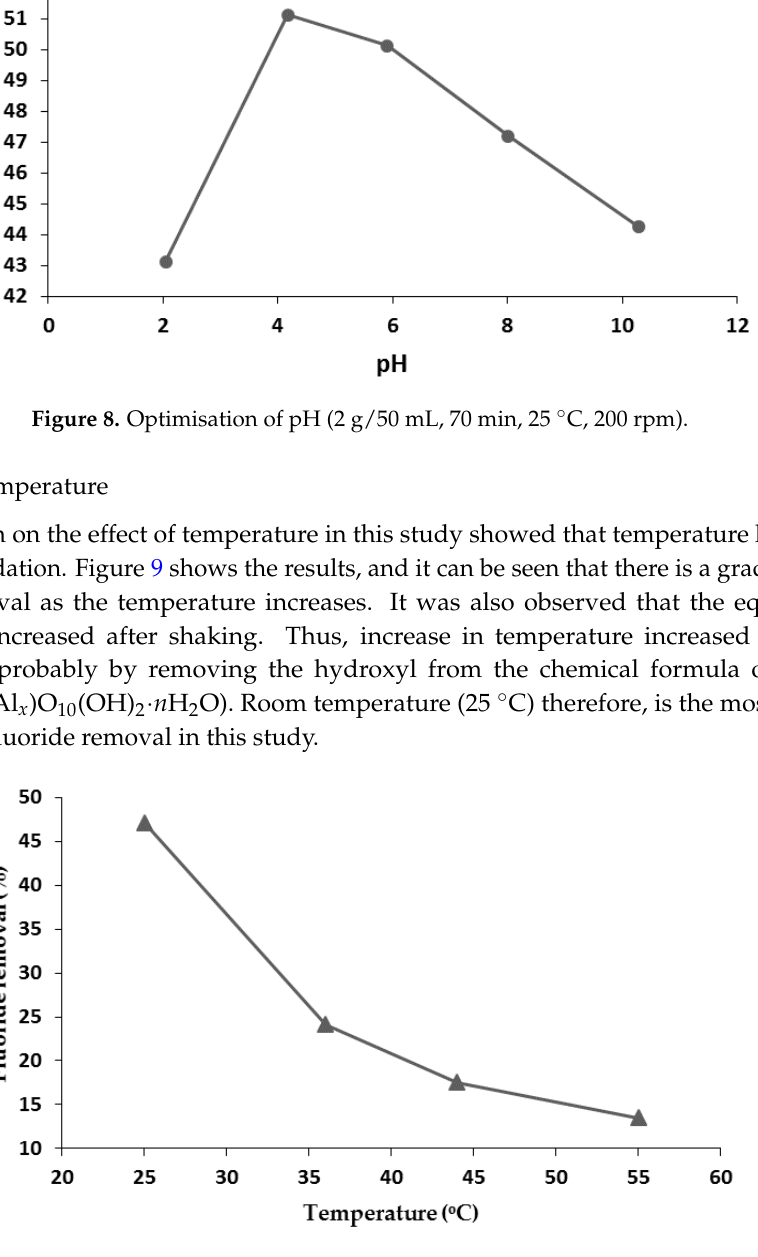
Figure 9. Optimisation of temperature (2 g/50 mL, 70 min, 200 rpm).